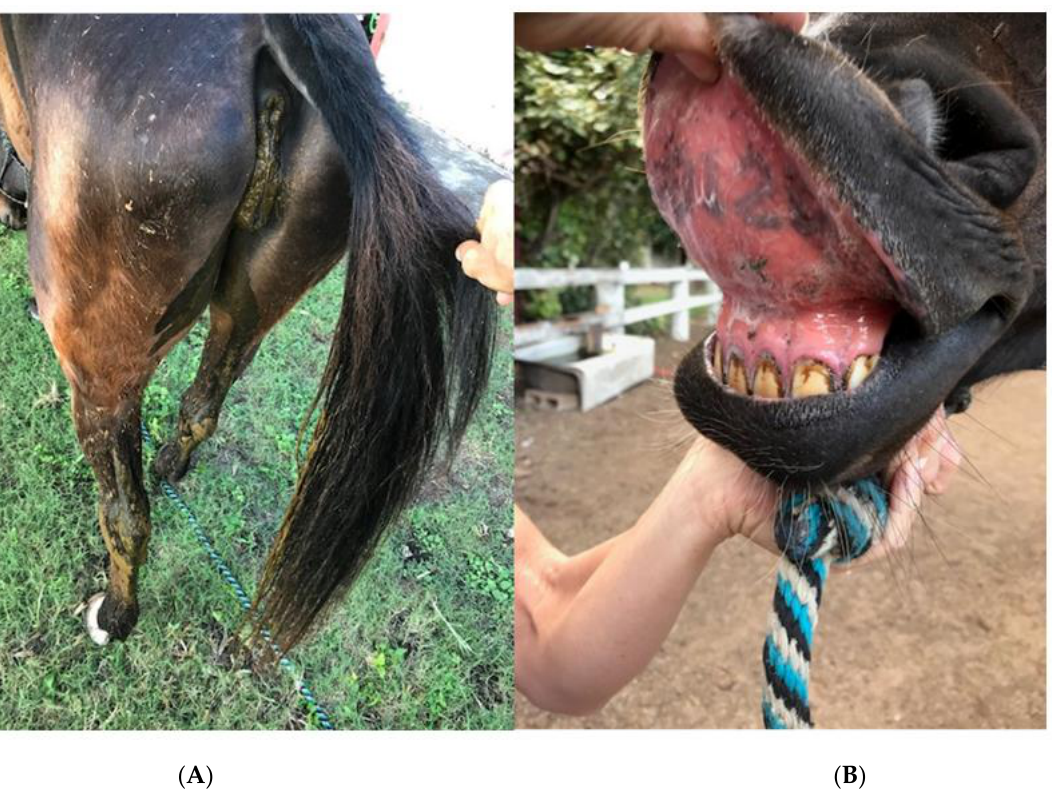
Figure 3. Symptoms of the late horse Serena: weight loss, lethargy, fasting, diarrhea ( A ); red gums with extensive ulcerations above the upper teeth and tongue ( B ) of the horse “Serena” before she died on 20 November 2020, on the north shore of Oahu island with symptoms of creeping indigo toxicity.